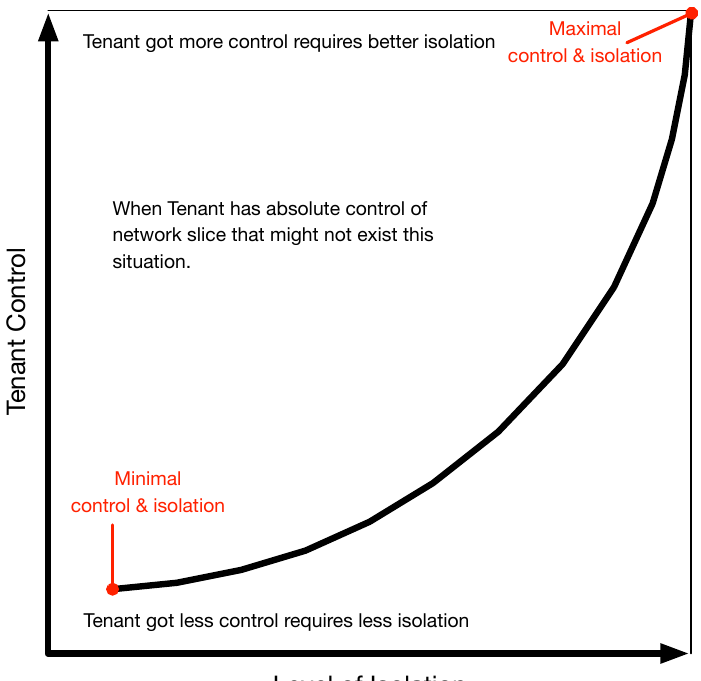
Figure 3. The tenant obtains more control of its slice with a higher isolation level since more shared functions are replaced by dedicated ones.